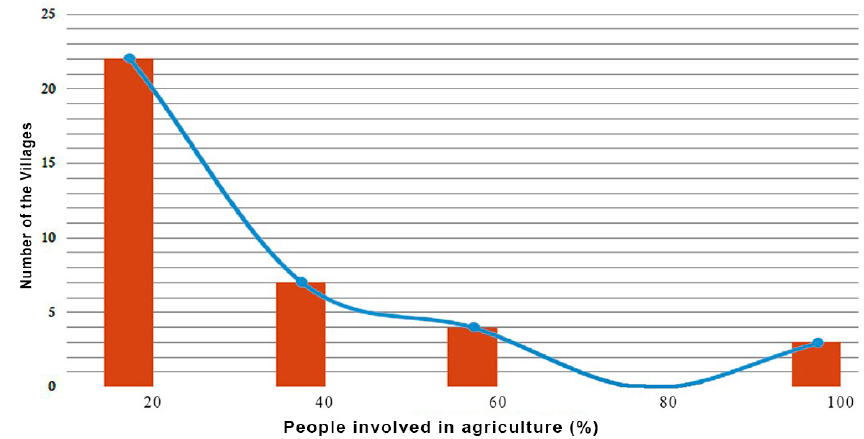
Figure 8. The histogram for the “people involved in agriculture” index. Table 9. Classification of the “people involved in agriculture” index with their weights. People Involved in Agriculture Index People Involved in Agriculture Villages Sub-Parameters Weights Potential Development